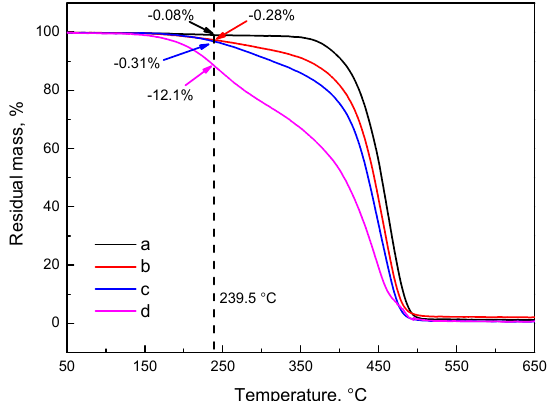
Figure 7. TG plots of ( a ) neat SBS; ( b ) aged SBS1 (150 °C × 3 h × 1 L/min); ( c ) aged SBS2 (180 °C × 3 h × 1 L/min); ( d ) aged SBS3 (150 °C × 48 h × 1 L/min).